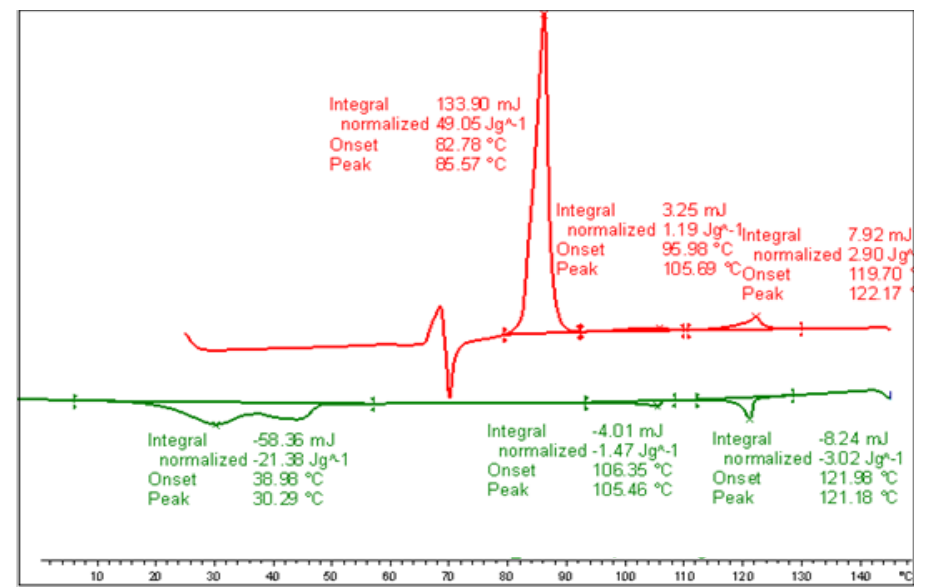
Figure 14. DSC studies (10 K/min) of the MGTP212 ; the values are taken from the first heating and cooling scans. Cr 85.6 (49.05) Nx 105.7 (1.19) N 122.2 (2.90) Iso (°C); Iso 121.2 (−3.02) N 105.5 (−1.47) Nx 30.3 (−21.38) Cr; the numbers in brackets are the transition enthalpies in J∙g −1